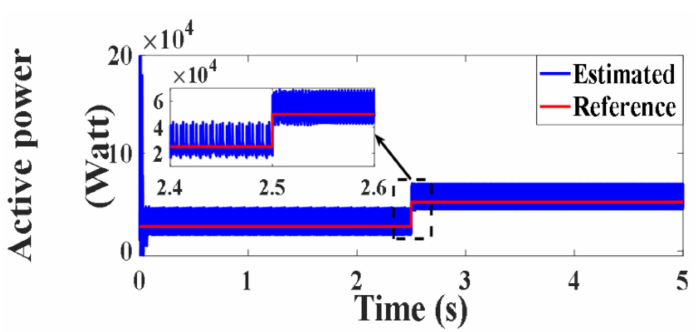
Figure 45. Active power under MPDTC (Watt).